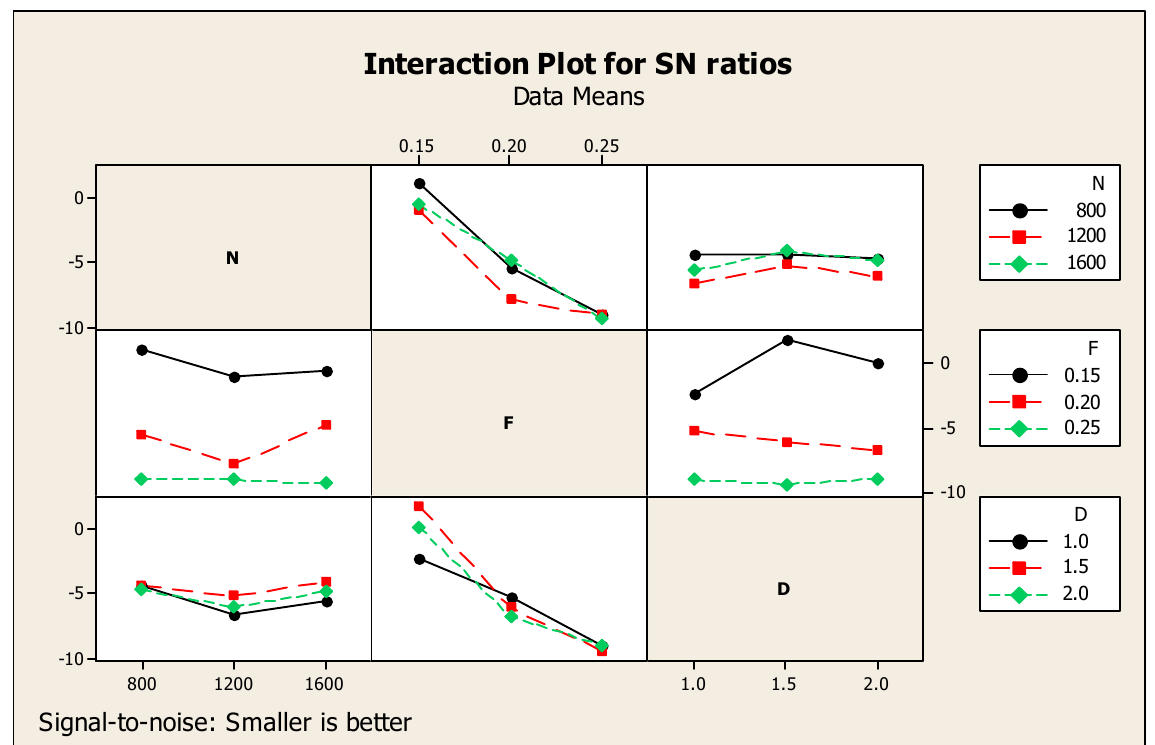
Figure 7. SR major effects diagram.